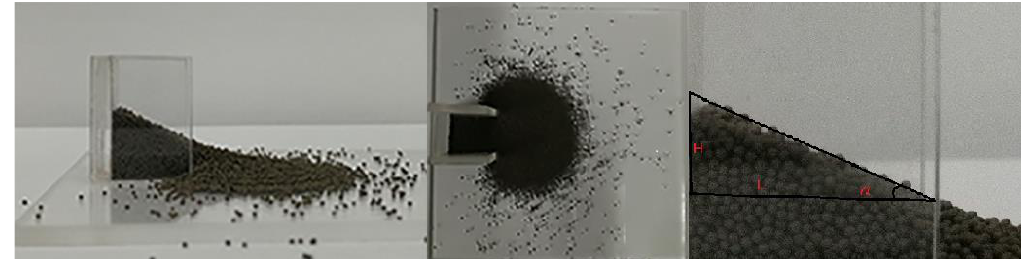
Figure 6. The experimental result of the angle of repose.